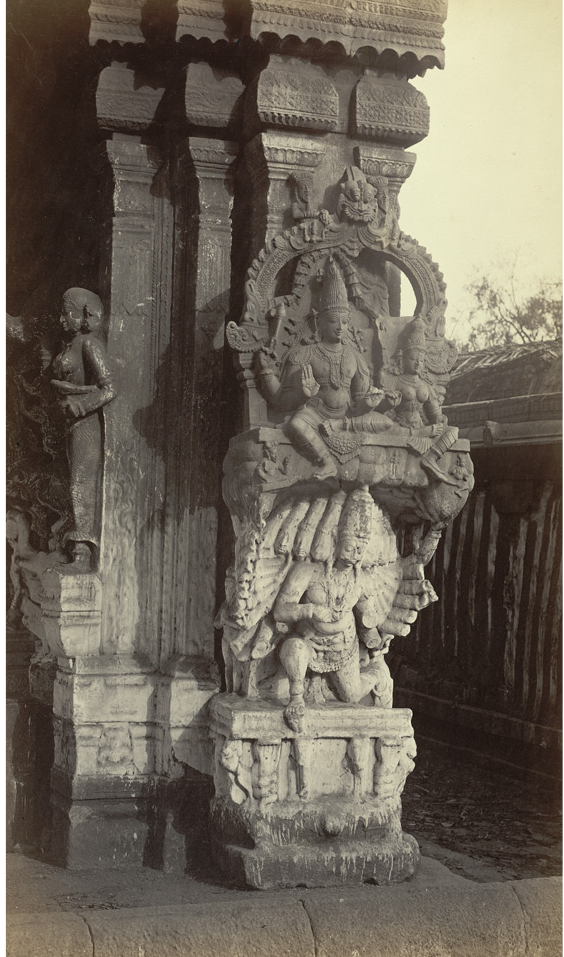
Figure 5. Madura. Trimul Naik's Portico [Pudu Mandapa]. Pillar at S.W. corner of building c. 1868, Edmund David Lyon